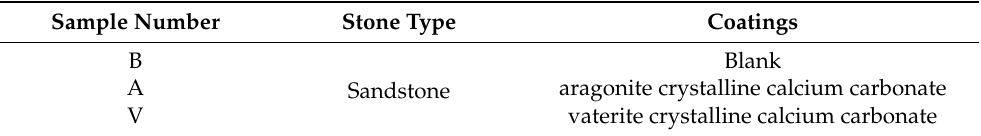
Table 1. Stone sample